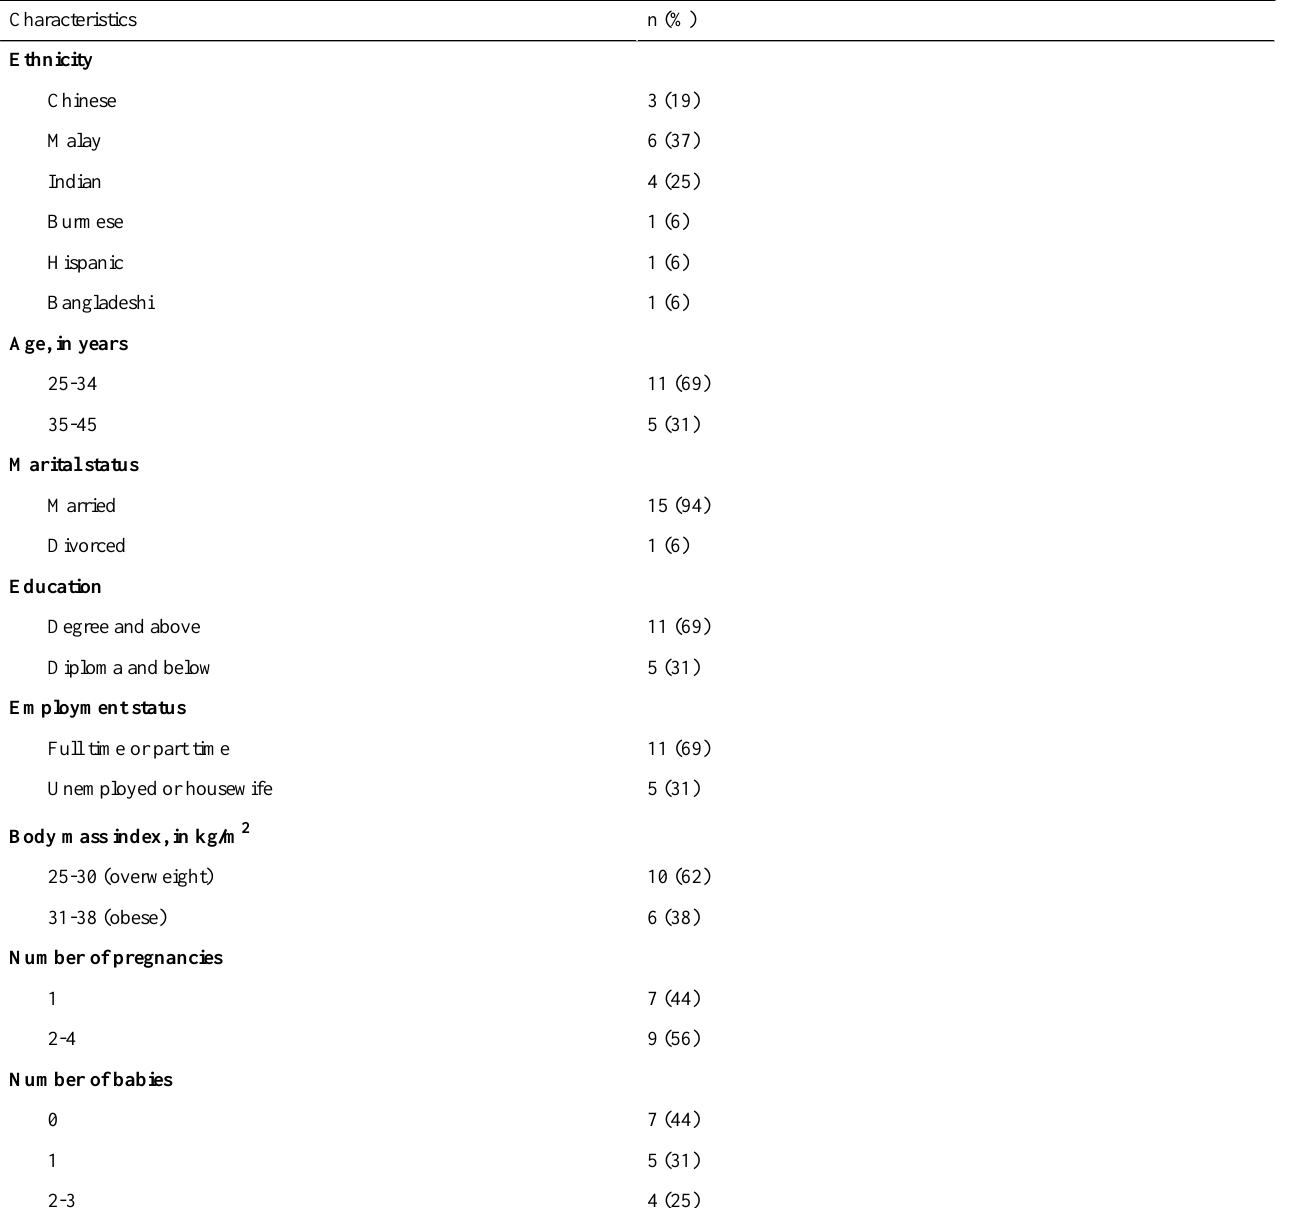
Table 2. Characteristics of interview participants